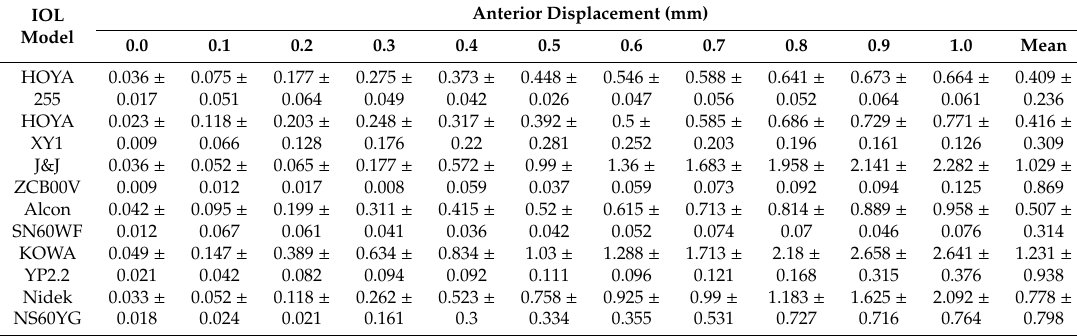
Table 3. Di ff erence in forces required for anterior IOL displacement among the various IOL